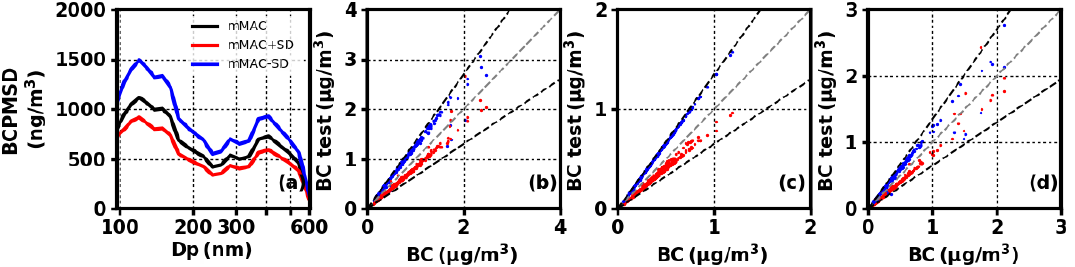
Figure 8. (a) The BCPMSD calculated by using the look-up table with the mean MAC (black line), the mean MAC plus the corresponding standard deviation (red line) and the mean MAC minus the corresponding standard deviation (blue line). The EBC derived by the look-up table with the mean MAC versus those derived by the look-up table with the mean MAC plus standard deviation (red dots) or the mean MAC minus standard deviation (blue dots) for (b) aerosol particles ranging from 97–602nm, (c) aerosol particles ranging from 97–240nm (fine mode) and (d) aerosol particles ranging from 240–602nm (coarse mode). The dashed black line represents the 35% deviation from the 1 : 1 line (dashed gray